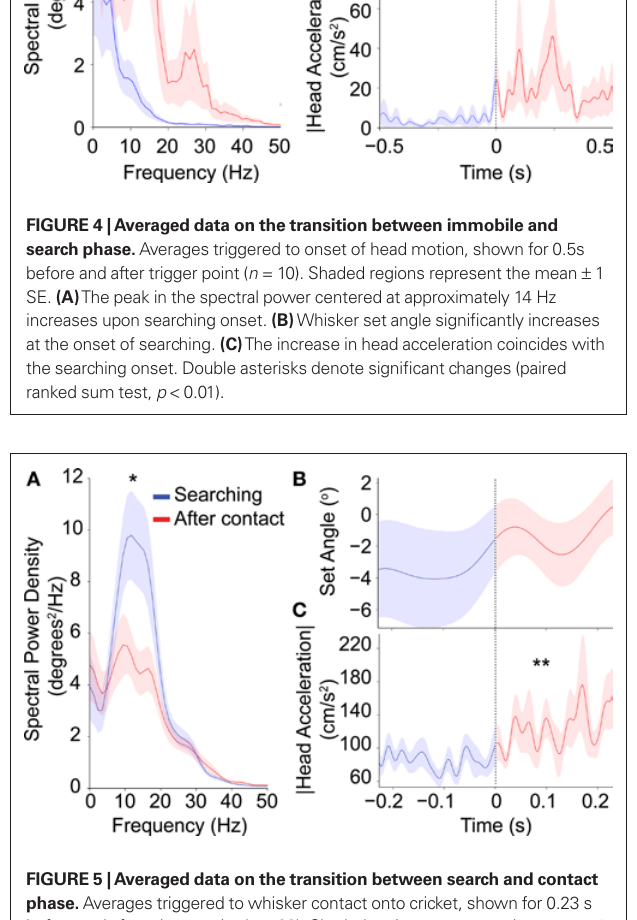
FigurE 5 | Averaged data on the transition between search and contact phase. Averages triggered to whisker contact onto cricket, shown for 0.23 s before and after trigger point ( n = 22). Shaded regions represent the mean ± 1 SE. (A) The peak in the spectral power centered at approximately 14 Hz decreases after whisker contact. (B) Average whisker set angle does not significantly change after whisker contact. (C) There was a small change in head acceleration magnitude after whisker contact. Single and double asterisks denote significant change (paired ranked sum test, p < 0.05, and < 0.01